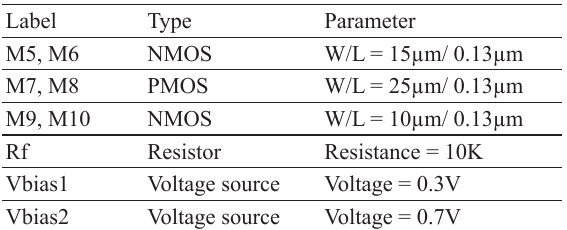
Circuit parameter for active